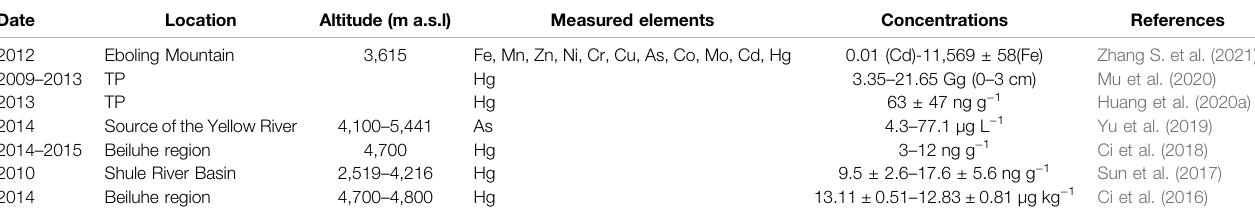
TABLE 1 | Summary of previous studies on permafrost samples in the TP.